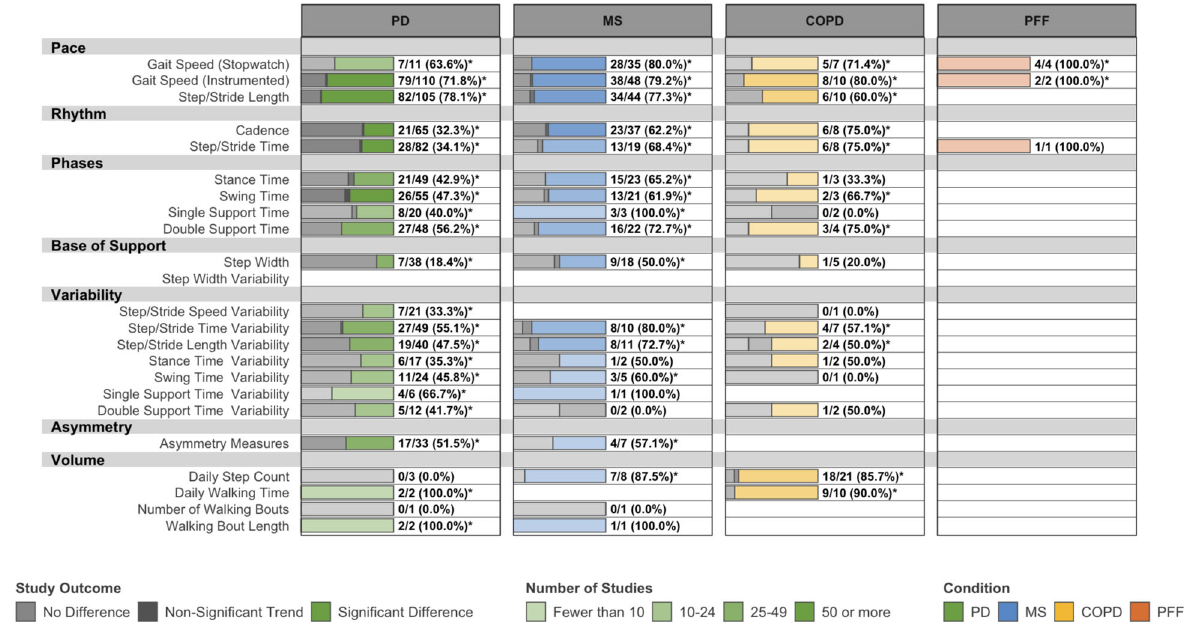
Fig. 3 Known-groups validity: number and outcome of eligible studies assessing differences in DMOs between patients and healthy controls. PD Parkinson ’ s disease, MS multiple sclerosis, COPD chronic obstructive pulmonary disease, PFF proximal femoral fracture. Data are presented as: Number of studies with statistically signi fi cant differences between groups/Total studies (%). DMOs known to be highly intercorrelated were grouped (i.e., step length and stride length), and all DMOs were organized according to previously established domains of gait. *Proportion of studies exceeds the expected false-positive rate as determined by Bernoulli hypothesis testing and Benjamini – Hochberg